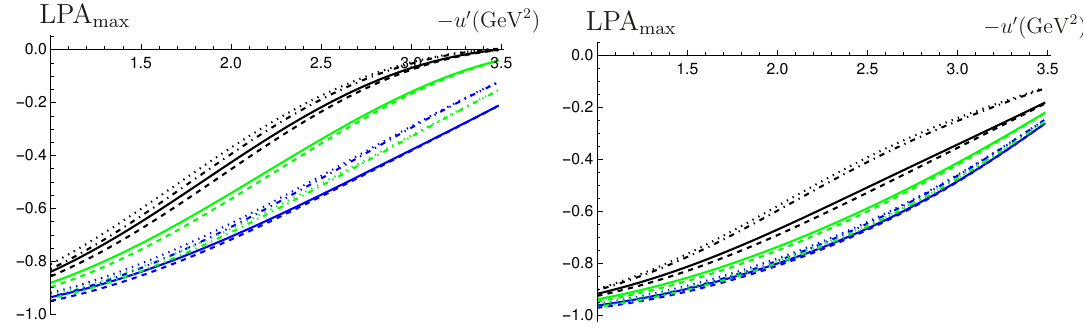
Figure 30 . The LPA at the fully-differential level for π + ( π − ) is shown as a function of ( − u 0 ) on the left (right), using M 2 = 4 GeV 2 and S = 20000 GeV 2 . The blue and green curves correspond γN γπ to contributions from the u quark ( H and ˜ H ) and d quark ( H and ˜ H ) GPDs respectively. u u d d The black curves correspond to the total contribution. The dashed (non-dashed) lines correspond to holographic (asymptotic) DA, while the dotted (non-dotted) lines correspond to the standard (valence) scenario.